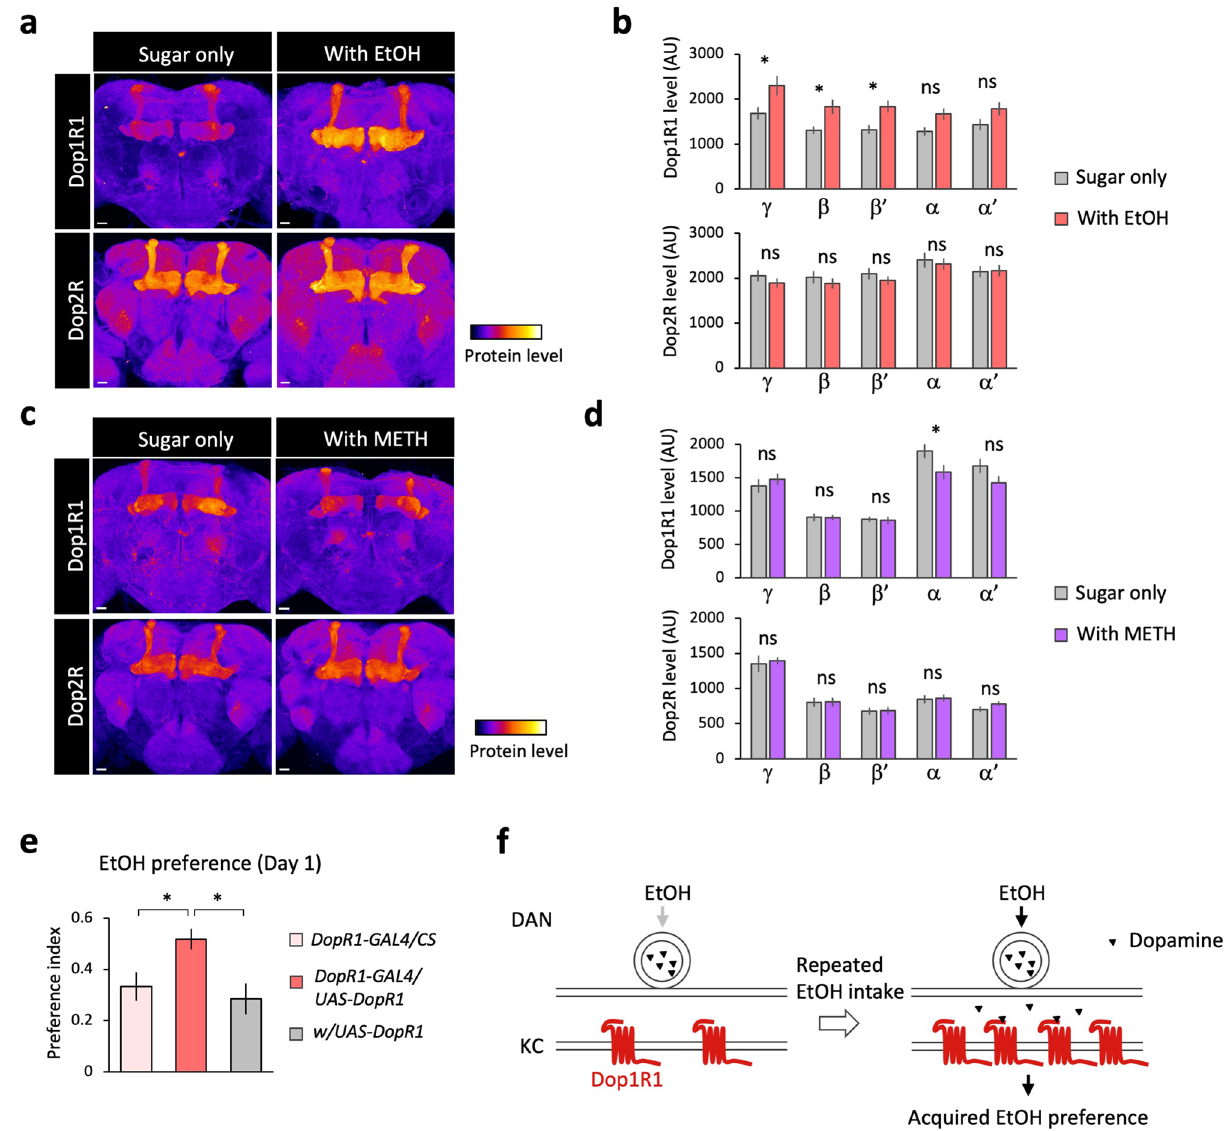
Figure 5. Experience-dependent increase of Dop1R1 protein mediates acquired preference for ethanol. ( a ) Ethanol intake increases the protein level of Dop1R1-Venus, but not Dop2R-Venus. Representative images of the z-projection are shown. Flies are offered with only 5% sucrose solution (left, “Sugar only”) or a choice of 5% sucrose and 5% sucrose with 15% ethanol (right, “With EtOH”) for 3 days in the CAFE assay. ( b ) Increased Dop1R1 (up) or Dop2R (down) protein in the medial lobe of the MB. Mean fluorescent intensity of Dop1R1- or Dop2R-Venus at the slice of the mushroom body lobes is compared between the groups (Sidak’s multiple comparison). Dop1R1; γ lobe: P = 0.0075, β lobe: P = 0.0350, β ′ lobe: P = 0.0405, α lobe: P = 0.2044, α ′ lobe: P = 0.2809. n = 16 and 14 for “Sugar only” and “With EtOH”, respectively. Dop2R; γ lobe: P = 0.9008, β lobe: P = 0.9467, β ′ lobe: P = 0.9151, α lobe: P = 0.9928, α ′ lobe: P > 0.9999. n = 8 and 11 for “Sugar only” and “With EtOH”, respectively. ( c ) Methamphetamine does not increase the protein level of Dop1R1 or Dop2R. Flies were offered with only 5% sucrose solution or a choice of 5% sucrose and 5% sucrose with 0.3 mM methamphetamine for 3 days in the CAFE assay. ( d ) Quantification of level of Dop1R1 (up) and Dop2R (down) in the MB lobes. Dop1R1; γ lobe: P = 0.9226, β lobe: P > 0.9999, β ′ lobe: P > 0.9999, α lobe: P = 0.0479, α ′ lobe: P = 0.1819 (Sidak’s multiple comparison). n = 10 for each group. Dop2R; γ lobe: P = 0.9899, β lobe: P > 0.9999, β ′ lobe: P > 0.9999, α lobe: P = 0.9999, α ′ lobe: P = 0.8845 (Sidak’s multiple comparison). n = 5 for each group. ( e ) Genetic overexpression of Dop1R1 enhances ethanol preference. Dop1R1 is overexpressed using the Dop1R1 knock-in 2A-GAL4 driver and 15% ethanol preference is measured for one day. F (2, 41) = 5.712, P = 0.0065 (one-way ANOVA), Dop1R1-GAL4/w vs. Dop1R1-GAL4/UAS-Dop1R1 : P = 0.0302, Dop1R1-GAL4/UAS-Dop1R1 vs. w/ UAS-Dop1R1 , P = 0.0055, n = 14, 16, 14 for Dop1R1-GAL4/w , Dop1R1-GAL4/UAS-Dop1R1 and w/UAS-Dop1R1 , respectively (Dunnett’s multiple comparison). ( f ) Model. Repeated ethanol intake alters the dopamine synapses by elevating the protein level of Dop1R1, thereby promotes further intake. DAN: dopamine neurons. KC: Kenyon cells. Bar graphs: mean ± SEM. *: P <